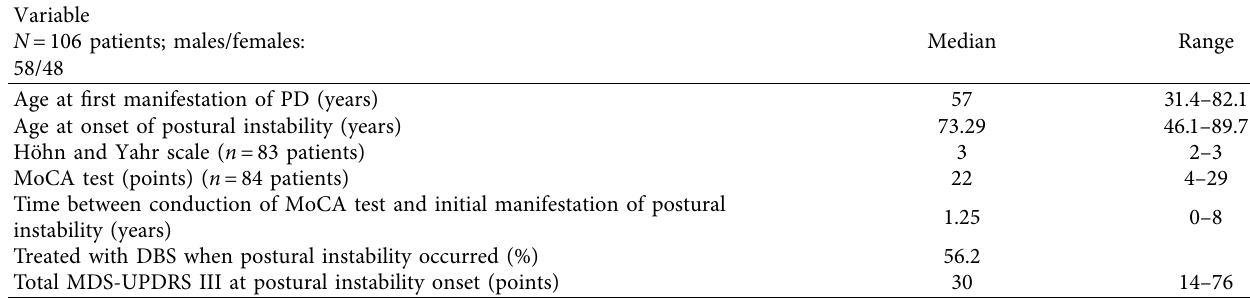
Table 1: Summary of